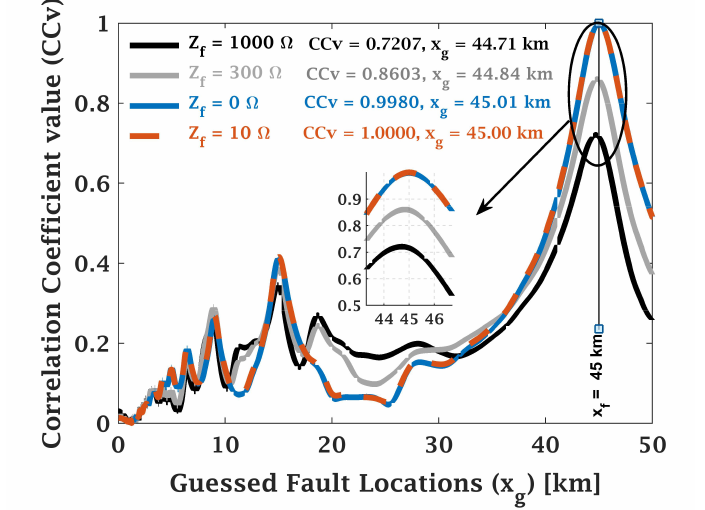
Figure 8. CCvs as a function of the GFL ( x g ): considering different values of Z f in the fault occurrence stage, while in the fault estimation stage, Z f = 10 Ω ; the test fault location is 45 km.